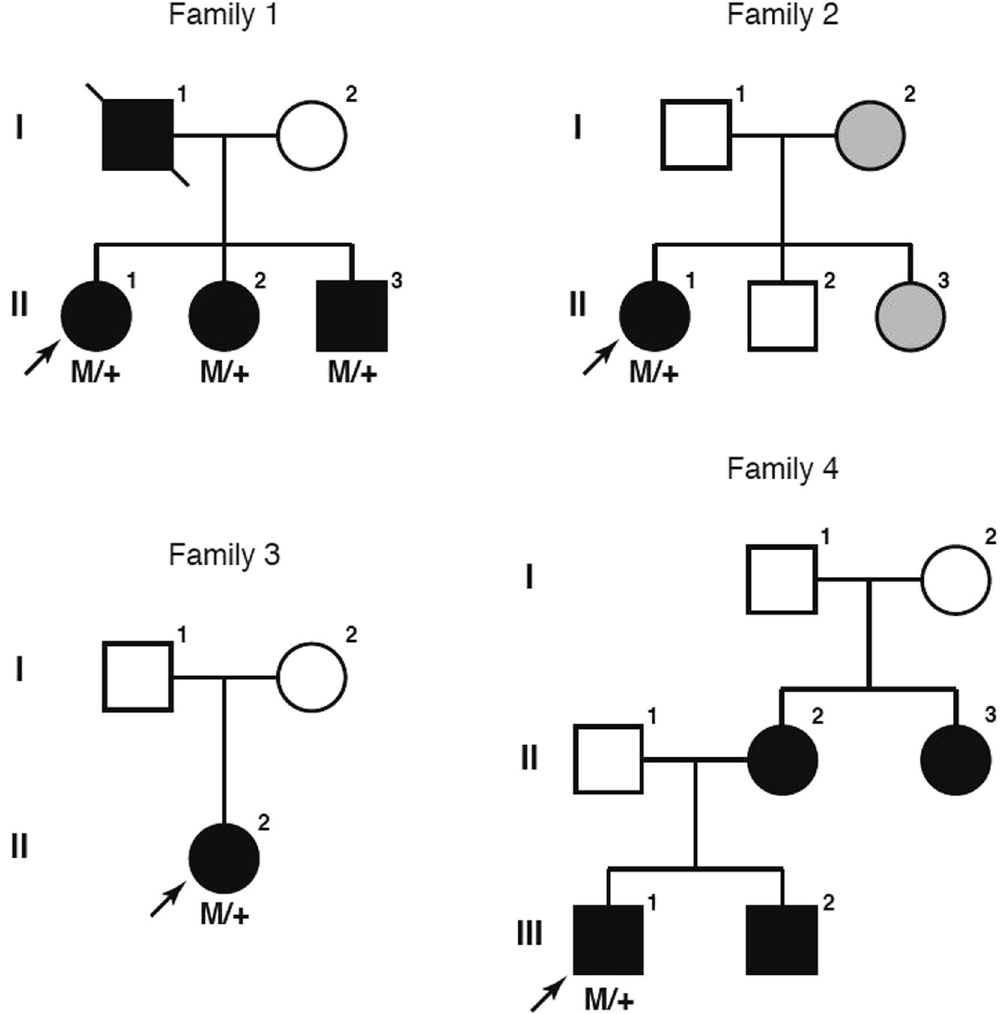
Figure 1. The pedigrees of the four IRD families in this study. “M” indicates the HK1 p.E851K mutation. Arrow indicates the proband. Grey coloring in the Family 2 indicates an unknown retinal